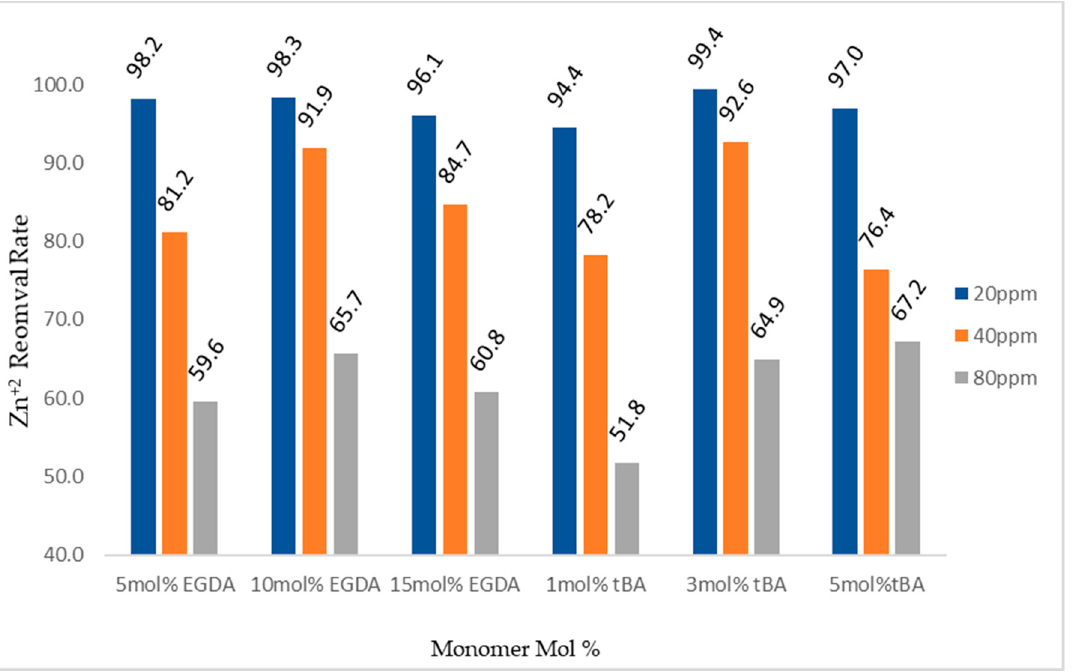
Figure 11. Gravity column removal rates for all tBA and EGDA imprinted polymers. The ppm values are for Zn +2 solutions. All polymers with varying EGDA contain no tBA. All polymers with varying tBA contain 5 mol % EGDA.